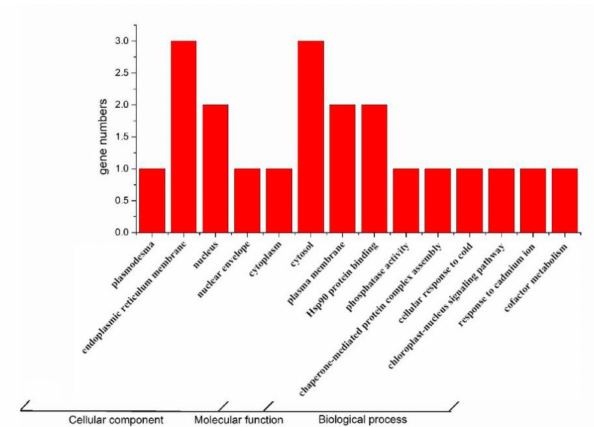
Figure 2. Gene ontology (GO) analysis output of tomato TPR genes. SlTPRs is involved in three kinds of biological processes, including 14 pathways including cellular component, molecular function and biological